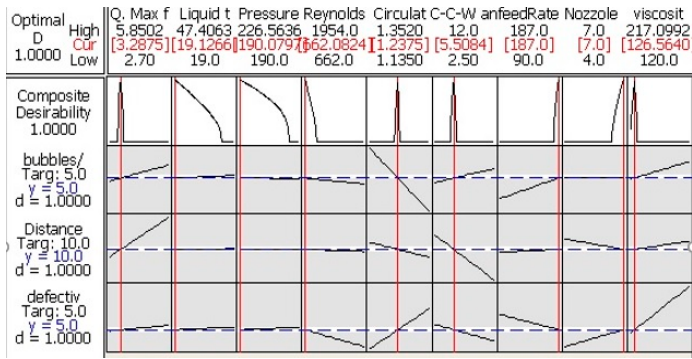
Figure 14. The optimization values for all factors in order to reduce bathtub defects.